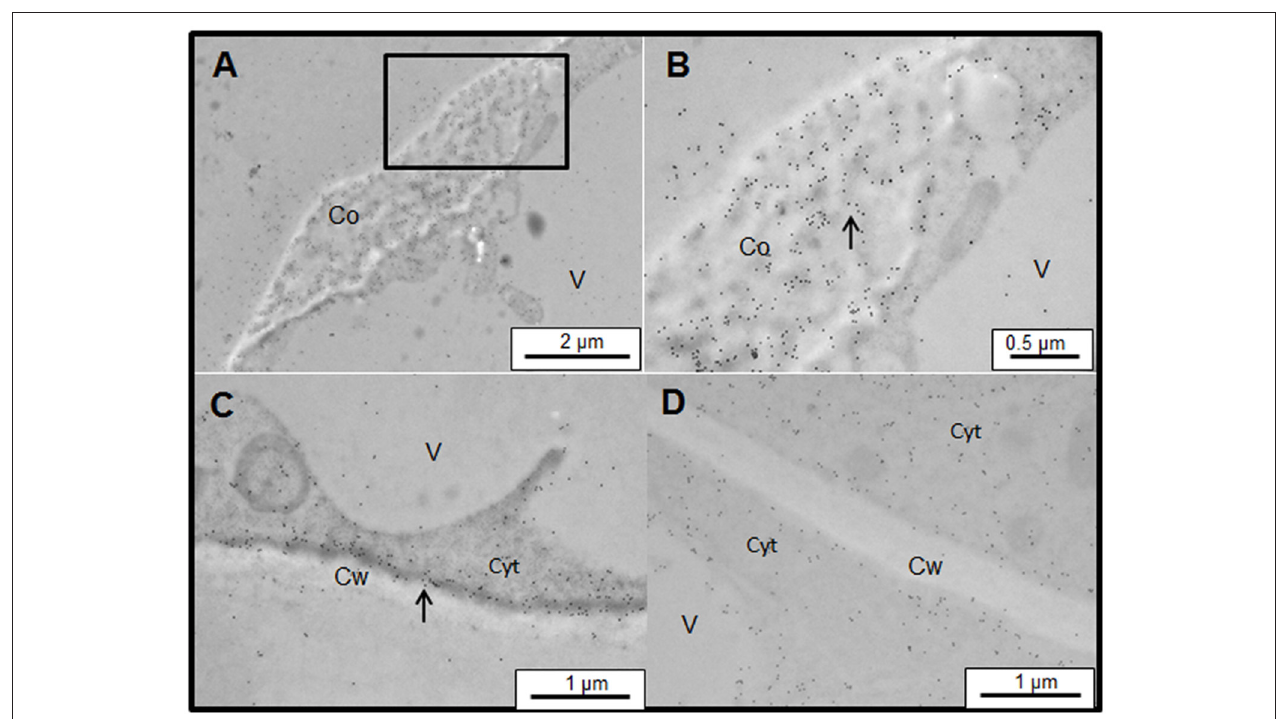
FIGURE 8 | Immunogold labeling of JIM13 AGP epitope associated with Yariv precipitates on samples of control (A–C) and salt-adapted (D) tobacco BY-2 cells. (A) JIM13 epitope was abundantly located on Yariv precipitates of control tobacco cells treated with 100 µ M Yariv reagent for 24 h. (B) Detail from image (A) showing that JIM13 labeling was specifically located in the dense filament (arrow). (C) JIM13 labeling was abundantly located between the plasma membrane and cell wall (arrow). (D) salt-adapted tobacco cells treated with 100 µ M Yariv reagent for 24 h showed a similar distribution of JIM13 epitope to untreated cells (see Figure 2